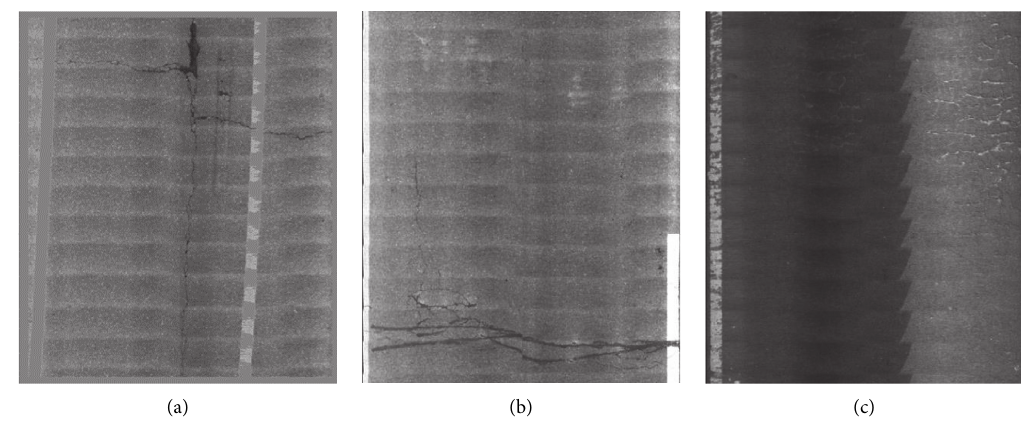
Figure 4: Samples for each crack class. (a) Longitudinal crack. (b) Transverse crack. (c) Block